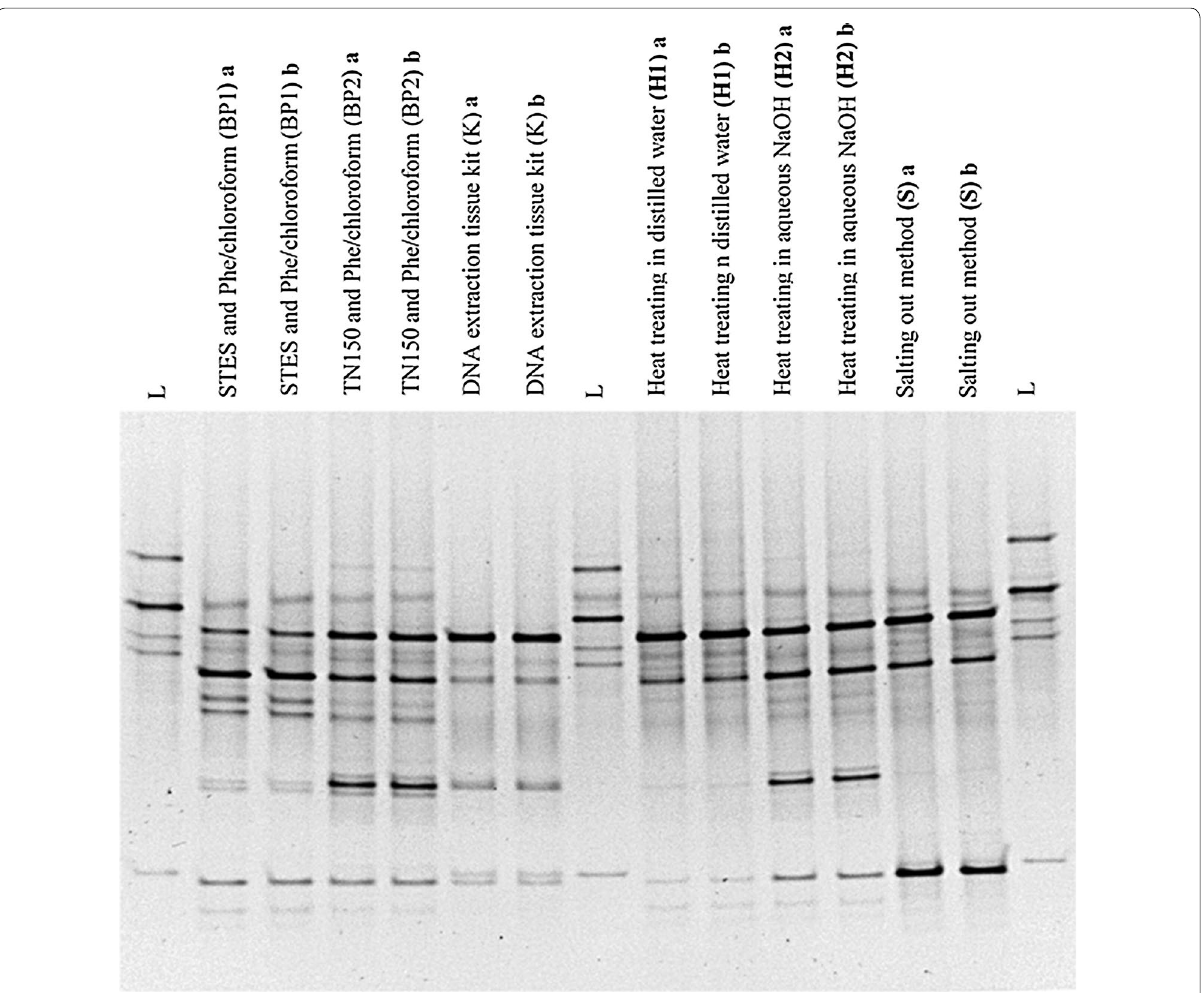
Fig. 4 A comparison of DGGE profiles of PCR amplified bacterial 16S rRNA gene for the specimen No: 2. DNA was extracted using six different DNA extraction methods. Bacterial fingerprinting profile was based on 30–55% denaturing gradient. “L” lanes represent the in house bacterial reference panel which includes S. aureus, Acinetobacter spp., Group B Streptococcus spp., E. faecalis, and E. coli from top to bottom respectively. Other lanes show bacterial fingerprinting profile of each extraction method in duplicate (a, b) for the specimen No. 2, collected from a subject with a chronic wound